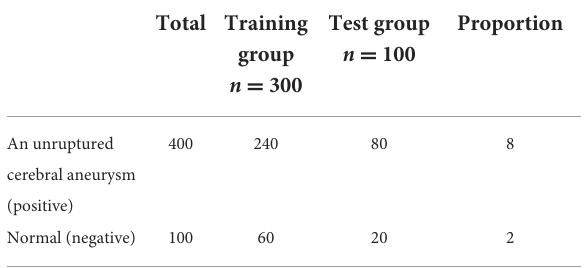
TABLE 1 The usage of the dataset selected for the